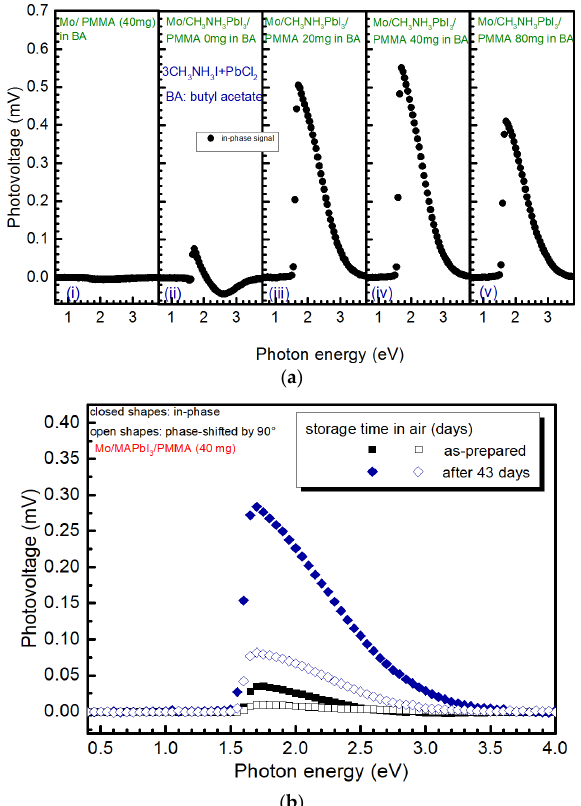
Figure 2 . ( a ) Modulated in ‐ phase (filled black symbols) for PMMA (40 mg/mL) deposited onto the Mo substrate (i) and for Mo/CH 3 NH 3 PbI 3 coated with PMMA at concentrations of 0, 20, 40 and 80 mg/mL ((ii—v), respectively); ( b ) shows the overview spectra of the in ‐ phase (filled symbols) and phase ‐ shifted by 90° (open symbols) SPV spectra for as ‐ prepared and after 43 days of storage in air for perovskite coated with PMMA at a concentration of 40 mg/mL.